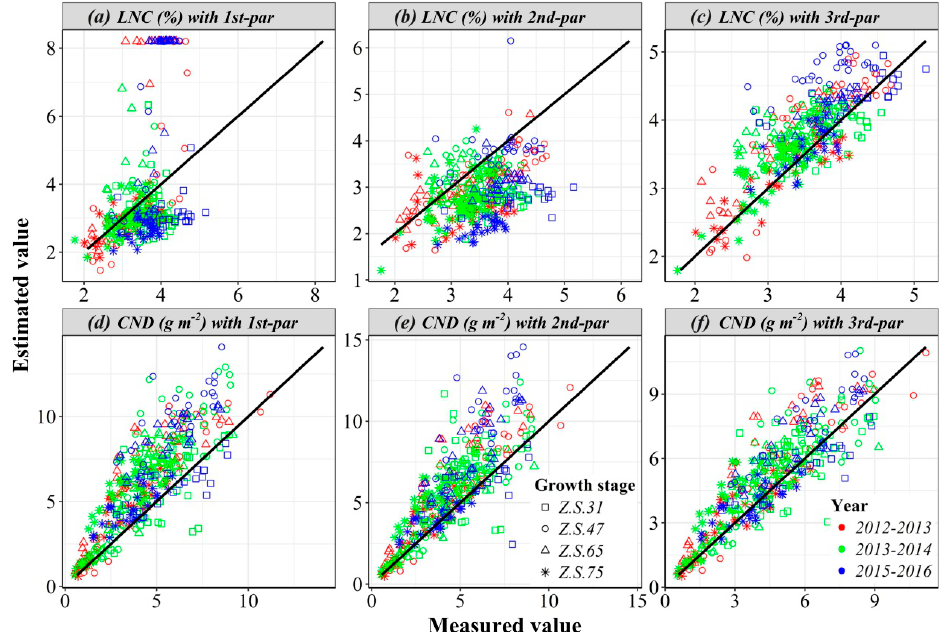
Figure 4. Comparison of measured and estimated values of LNC ( a – c ) and CND ( d – f ) based on the N-PROSAIL model in winter wheat across the calibration set.